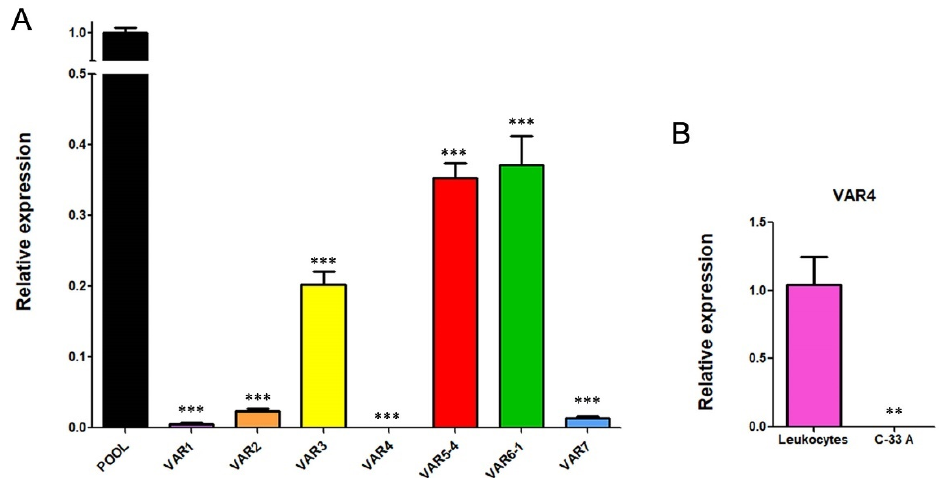
Figure 9. RIPOR2 variants expressed in C-33 A cells. ( A ) RT-qPCR showing the basal levels of the transcriptional variants, compared to RIPOR2-pool levels. ( B ) Expression of variant 4 in lymphocytes compared to C-33 A cells. *** p < 0.0001, ** p = 0.0066.